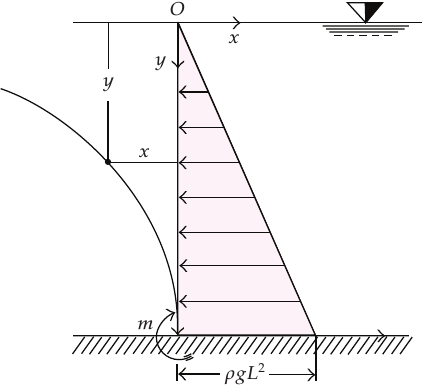
Figure 6: Submerged vertical rod under hydrostatic